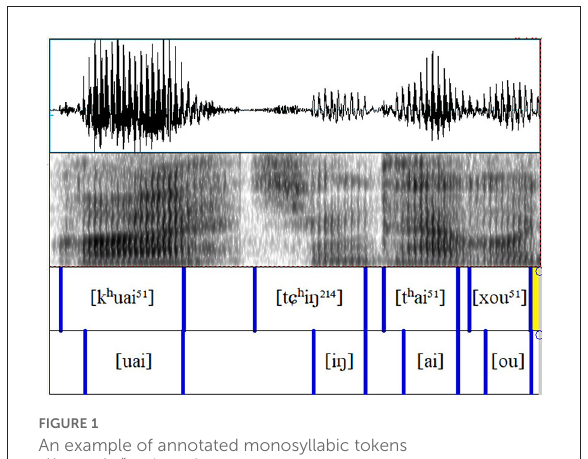
FIGURE1 An example of annotated monosyllabic tokens “ 快 kuài 请 qˇıng 太 tài 后 hòu (Go and invite the Empress Dowager!)”.